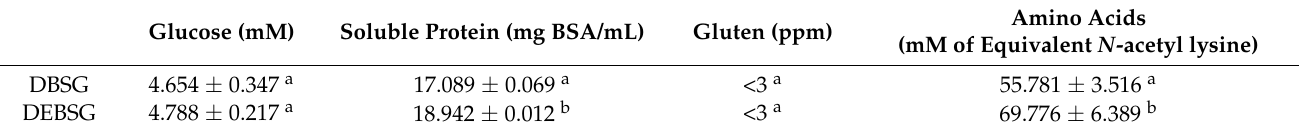
Table 1. Bioaccessibility of glucose, gluten, free amino acids and soluble protein in duodenal digests. Amino Acids Glucose (mM) Soluble Protein (mg BSA/mL) Gluten (ppm) (mM of Equivalent N -acetyl lysine) DBSG 4.654 ± 0.347 a 17.089 ± 0.069 a <3 a 55.781 ± 3.516 a DEBSG 4.788 ± 0.217 a 18.942 ± 0.012 b <3 a 69.776 ± 6.389 b Different letters within the same column show significant differences ( p < 0.05). BSA: bovine serum albumin; AGEs: advanced glycation end products; DSG: brewers’ spent grain intestinal digest; DEBSG: extruded brewers’ spent grain intestinal